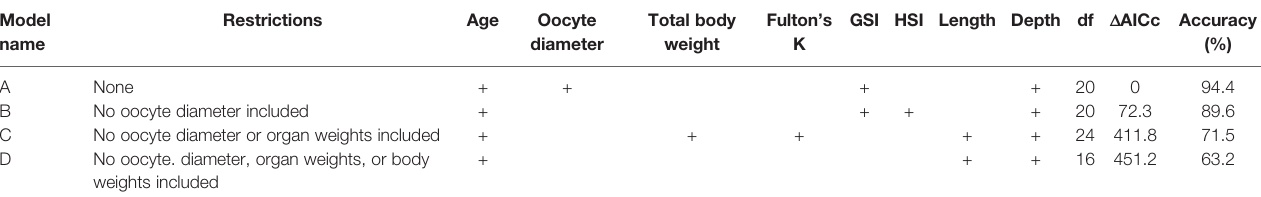
TABLE 2 | Summary of models (Models A-D) predicting female Paci fi c halibut reproductive phase, including model name, logistical restrictions, variables retained in best- fi t models denoted by a “ + ” , degrees of freedom (df), change in AICc from the best model ( D AICc), and the percent accuracy de fi ned as the number of correct predictions out of